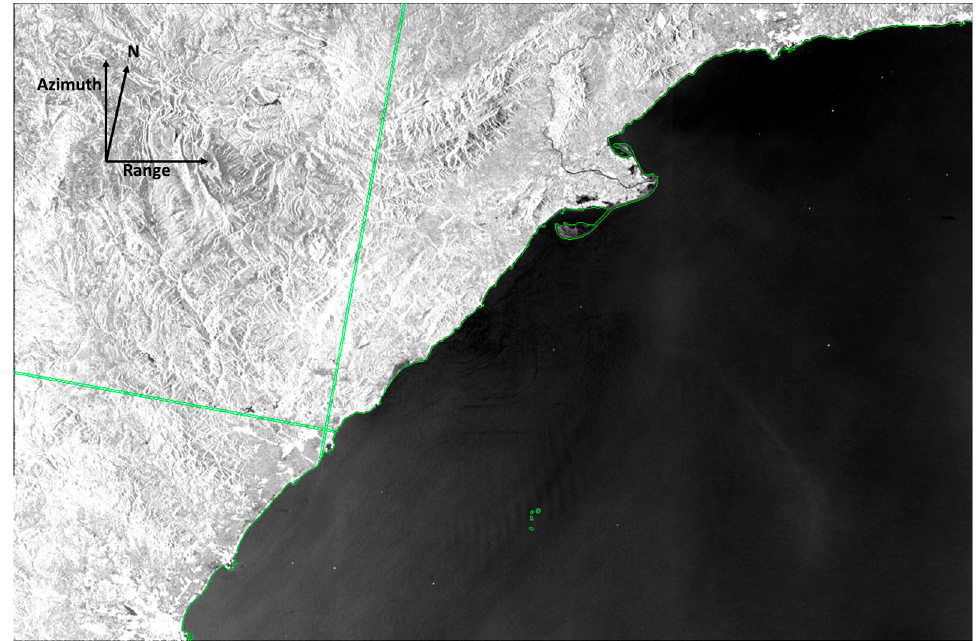
Figure 5. VV polarization of the Sentinel-1 image used in this example. The area is the Mediterranean coast of Spain between the cities of Valencia ( bottom left ) and Tarragona ( top right ). Image size is 250 km × 167 km. A coastline from OpenStreetMap buffered by 250 m is overlaid in green. The green lines on land reflect the tiled storage structure of the pre-buffered coastline. The Sentinel-1 image ID is: S1A_IW_GRDH_1SDV_20160704T175421_20160704T175446_012002_012865_965A.SAFE.